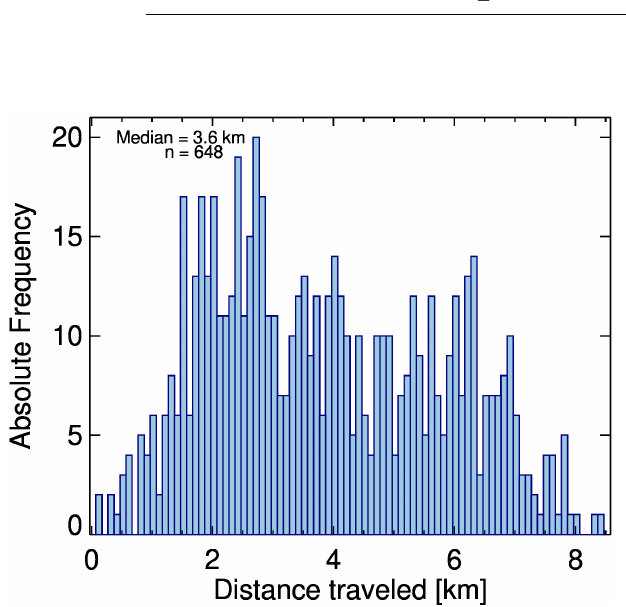
Figure 6. Distance between launch and landing for all dropsondes during OTREC.